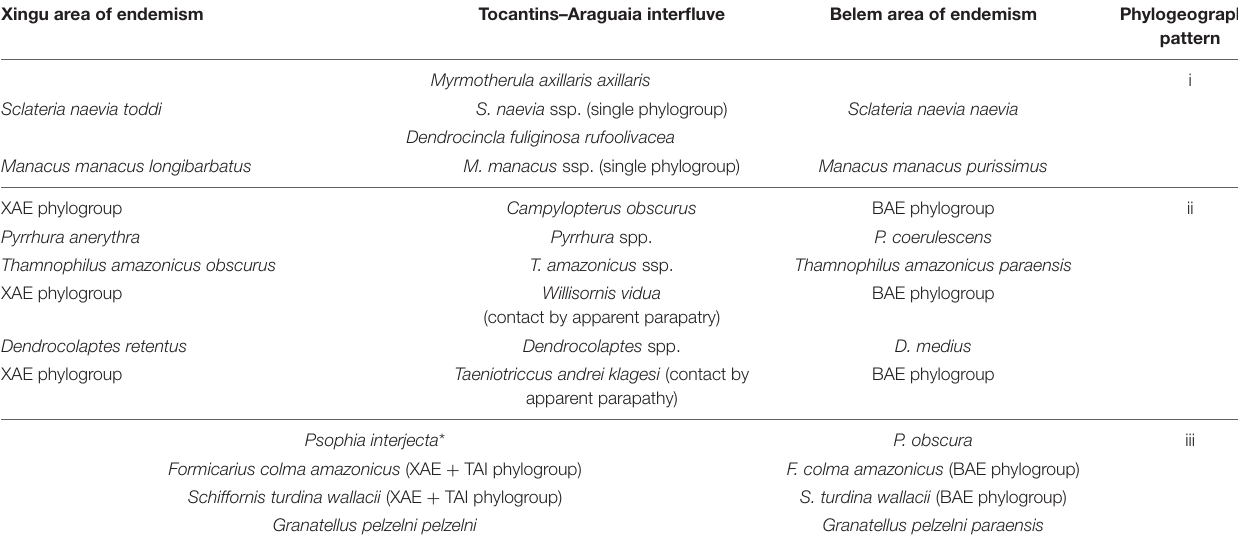
TABLE 1 | List containing 14 avian lineages included in the molecular analyses and the taxon present in each of the major areas sampled in this study. Xingu area of